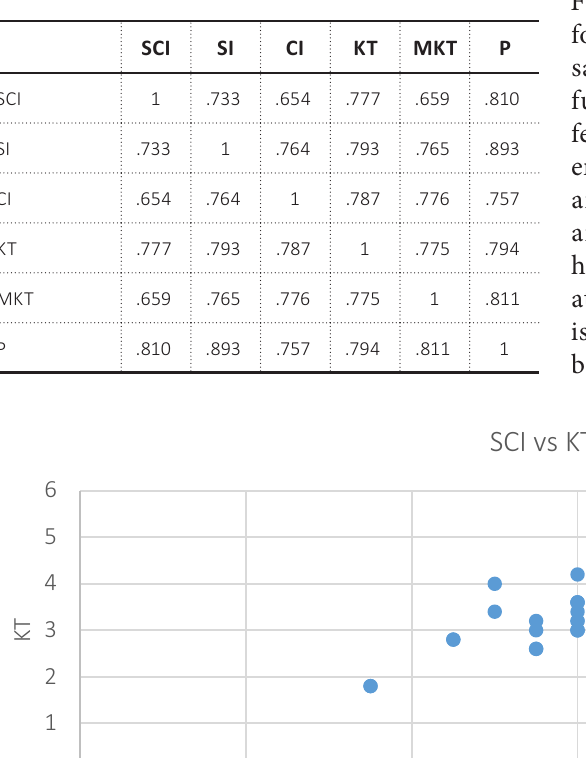
Table 3. Correlation between integration management factors and performance